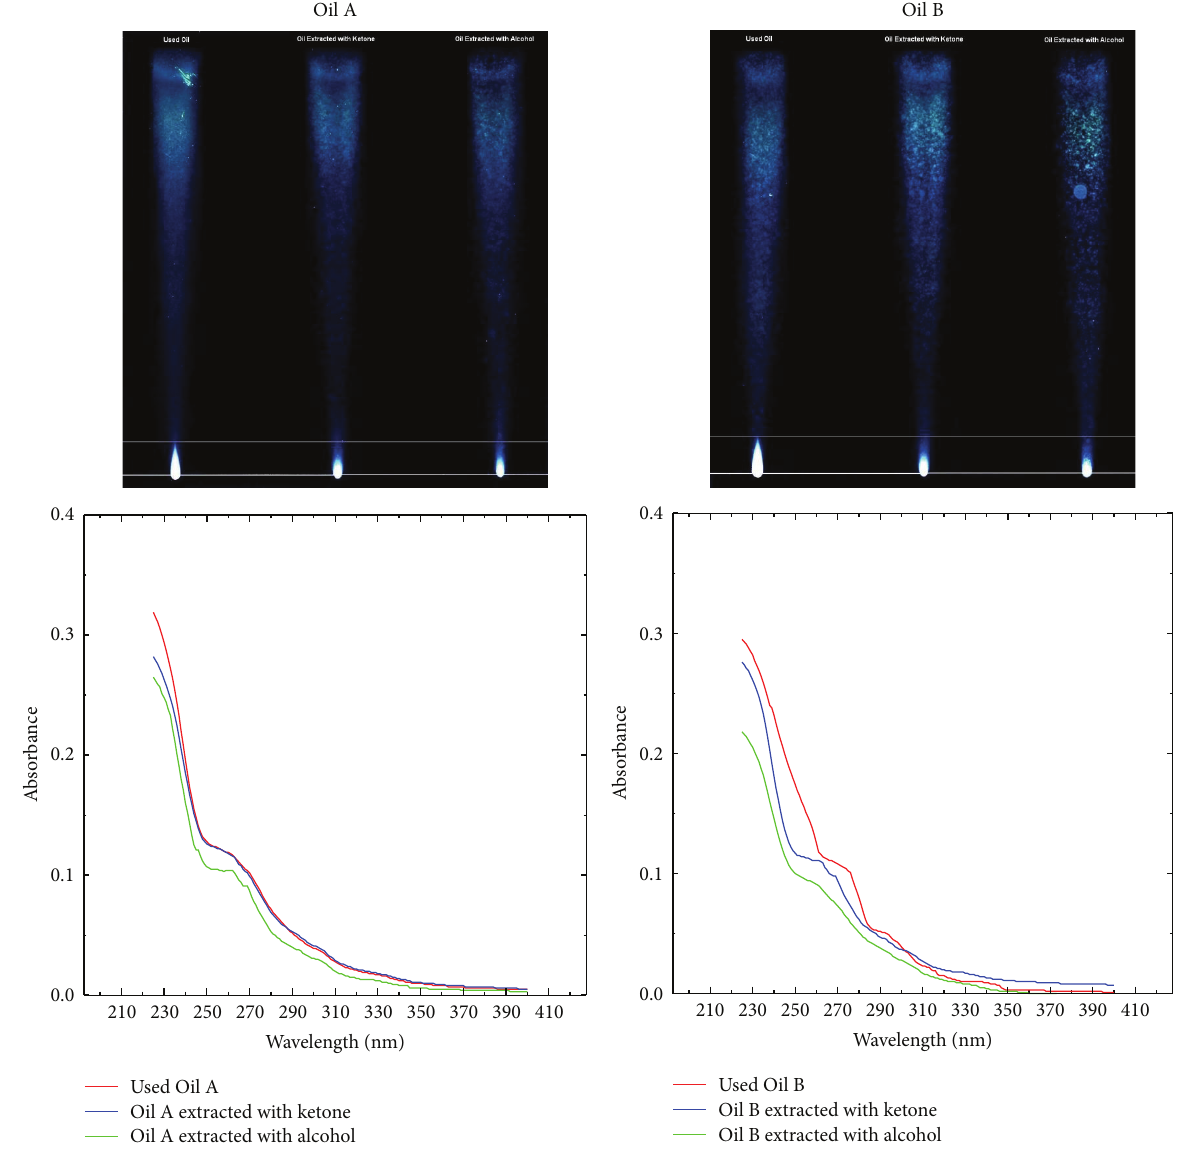
Figure 6: Processed images of the TLC plates developed for the comparative analyses of two lubricant samples along with the corresponding UV analyses illustrating the effect of the removal of sludge containing PAH upon extraction of spent lubricant samples with ketone and alcohol using corresponding optimum extraction parameters for the two